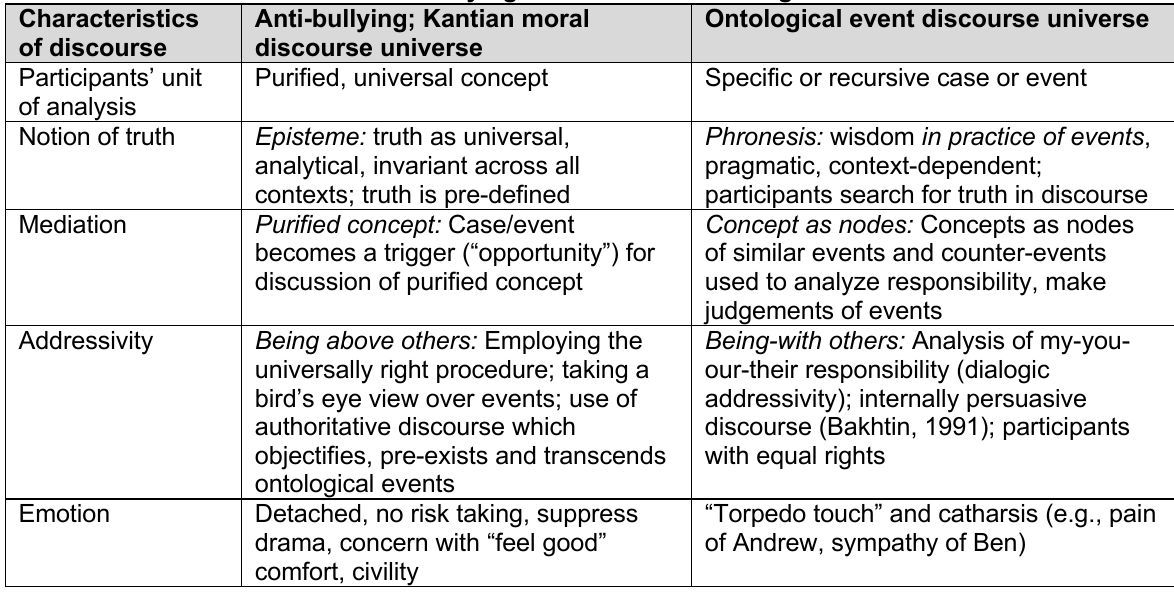
Table 1: Characteristics of the anti-bullying discourse and ontological event discourse universes